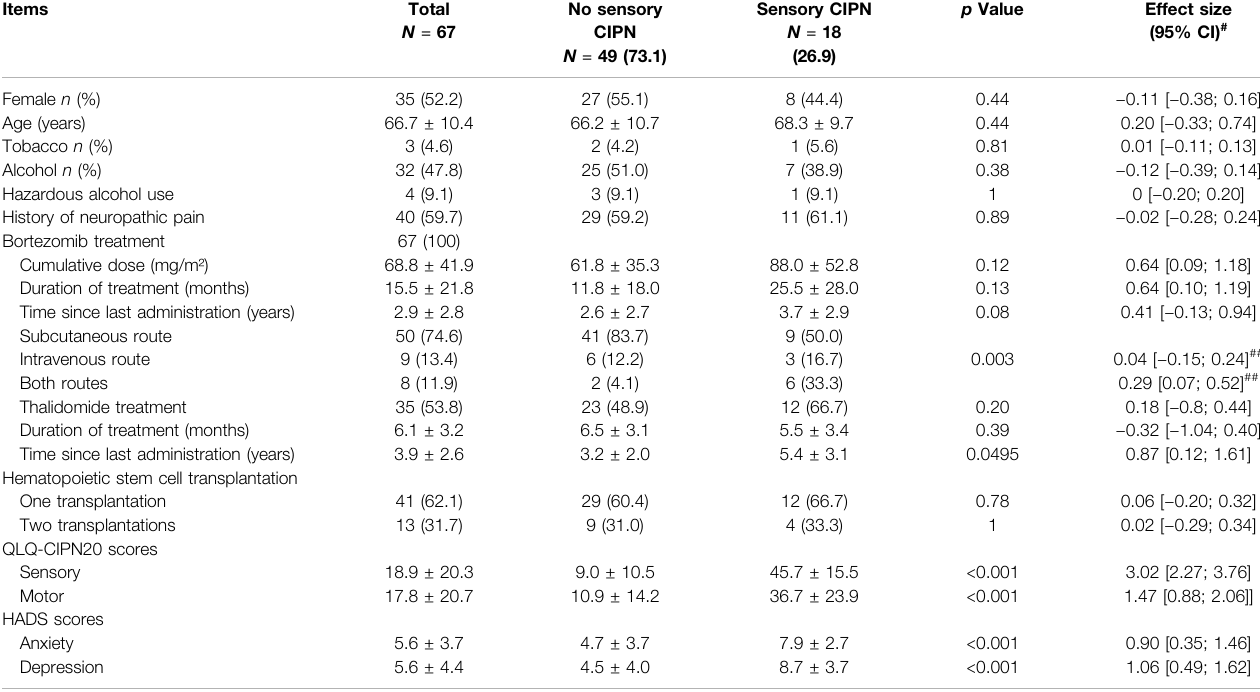
TABLE 1 | Characteristics of the analyzed patients ( N (cid:1) 67).